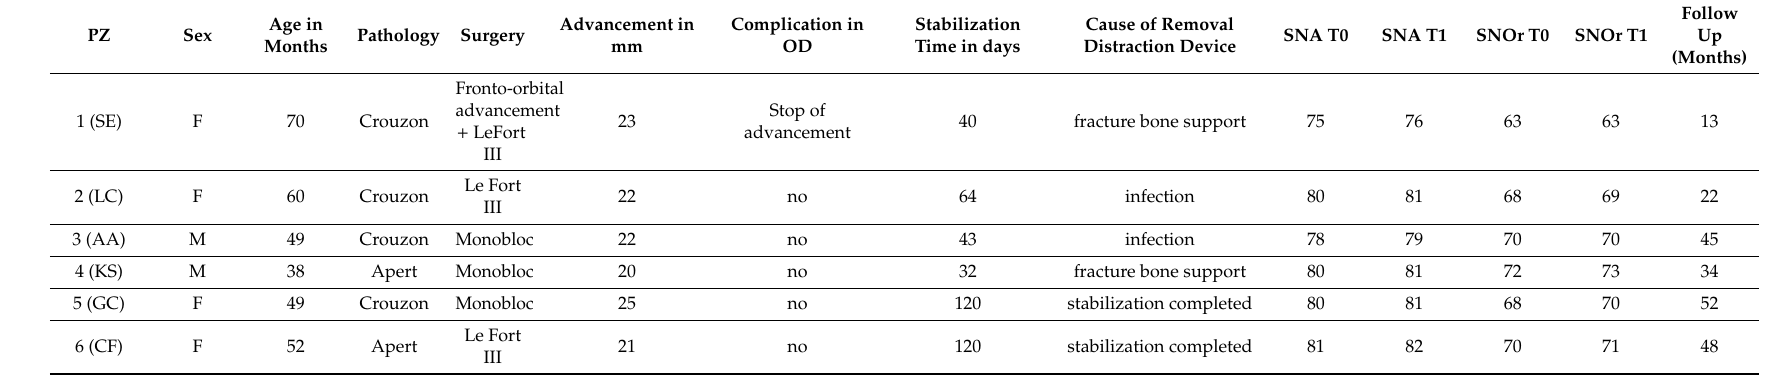
Table 1. Children treated with Osteodistraction protocol for therapy of craniofacial malformations. In patients 1, 2, 3, 4 the OD (OsteoDistraction) was removed before the end of bone stabilization because of severe complications. The OD was substituted with MAC. Patients 5 and 6 used MAC at the end of the stabilization time to improve the consolidation of callus bone. This table describes the splanchnocranium position before application of MAC and after 1